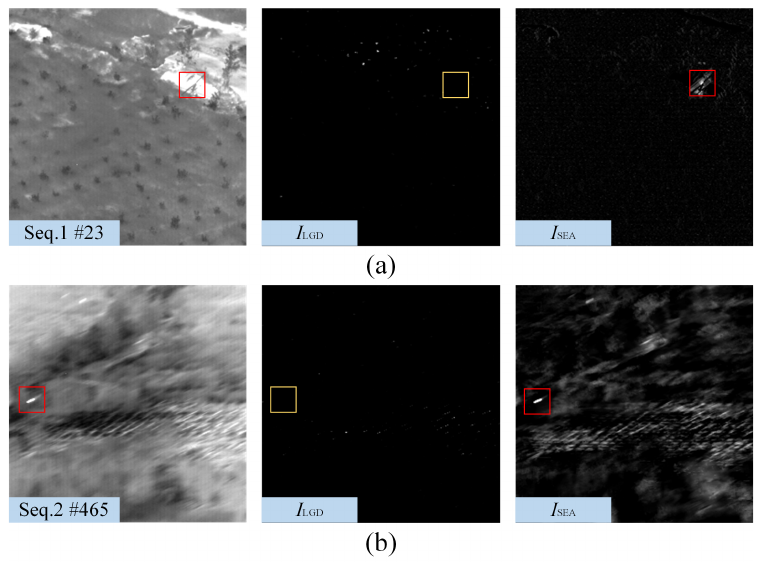
Figure 13. Two examples of missed detection. The original image, I LGD map, and I SEA map are shown in turn, and the actual target area is marked with a red box, the missed target is marked with a yellow box. ( a ) The target submerged by the high-brightness background. ( b ) The target under blurry